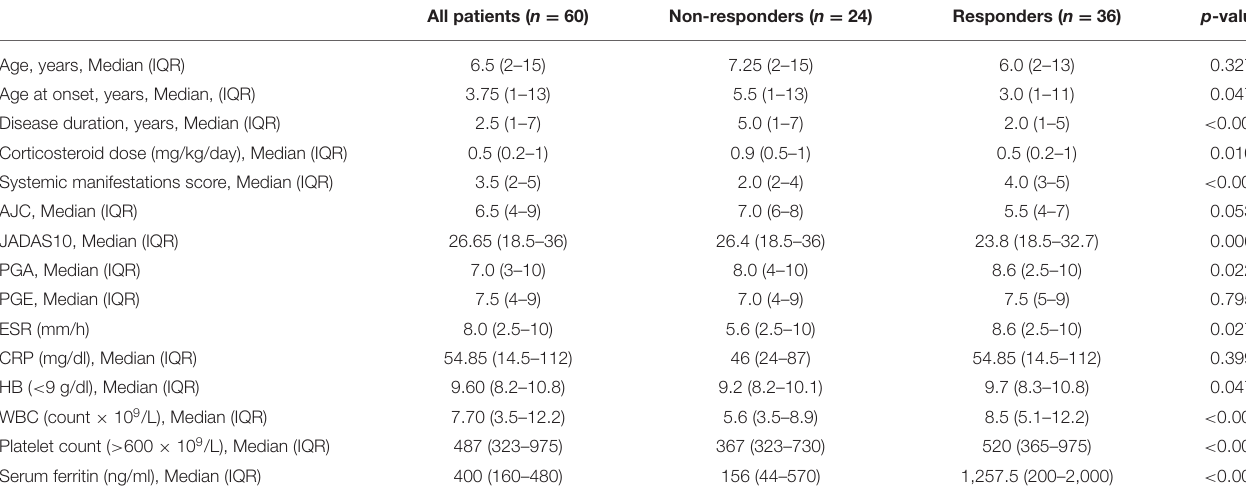
TABLE 2 | Baseline demographic and clinical data of all systemic JIA patients including the responders and non-responders to tocilizumab therapy. All patients ( n =